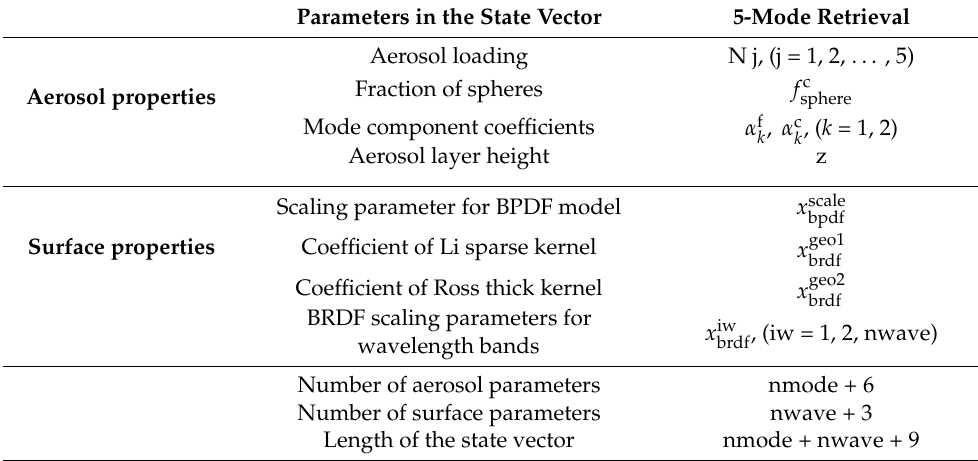
Table 3. State vector for 5-mode